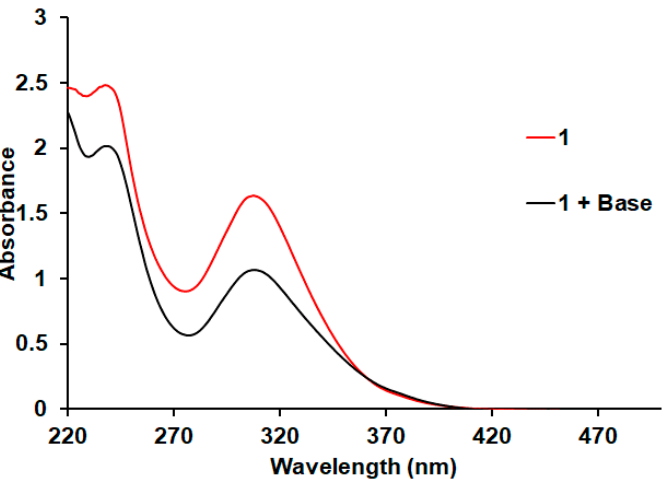
Figure 9. UV–Vis spectra of a MeOH solution of 1 (0.028 mM) (black line) and of 1 (0.028 mM) + But 4 NOH (0.028 mM).